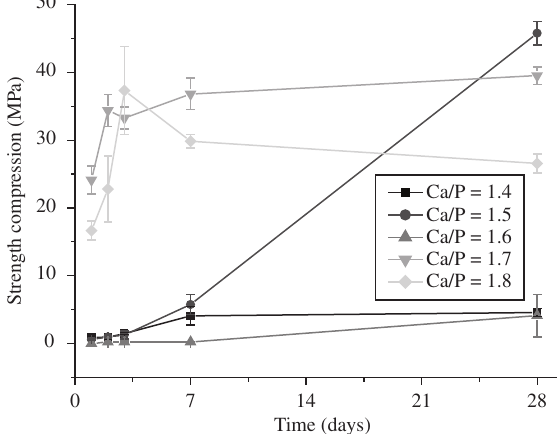
Figure 5. Measures of strength under compression of hydrated specimens as function of time as